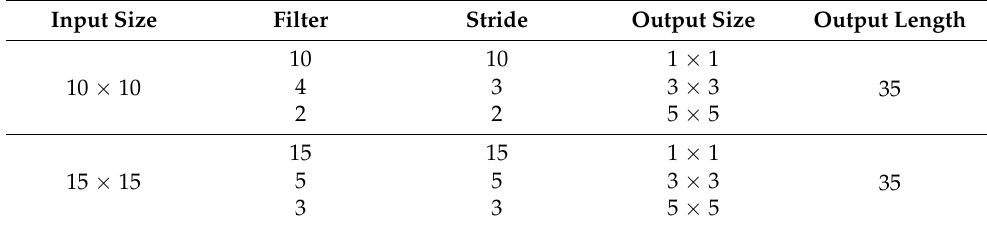
Table 1. Example of three-level SPP